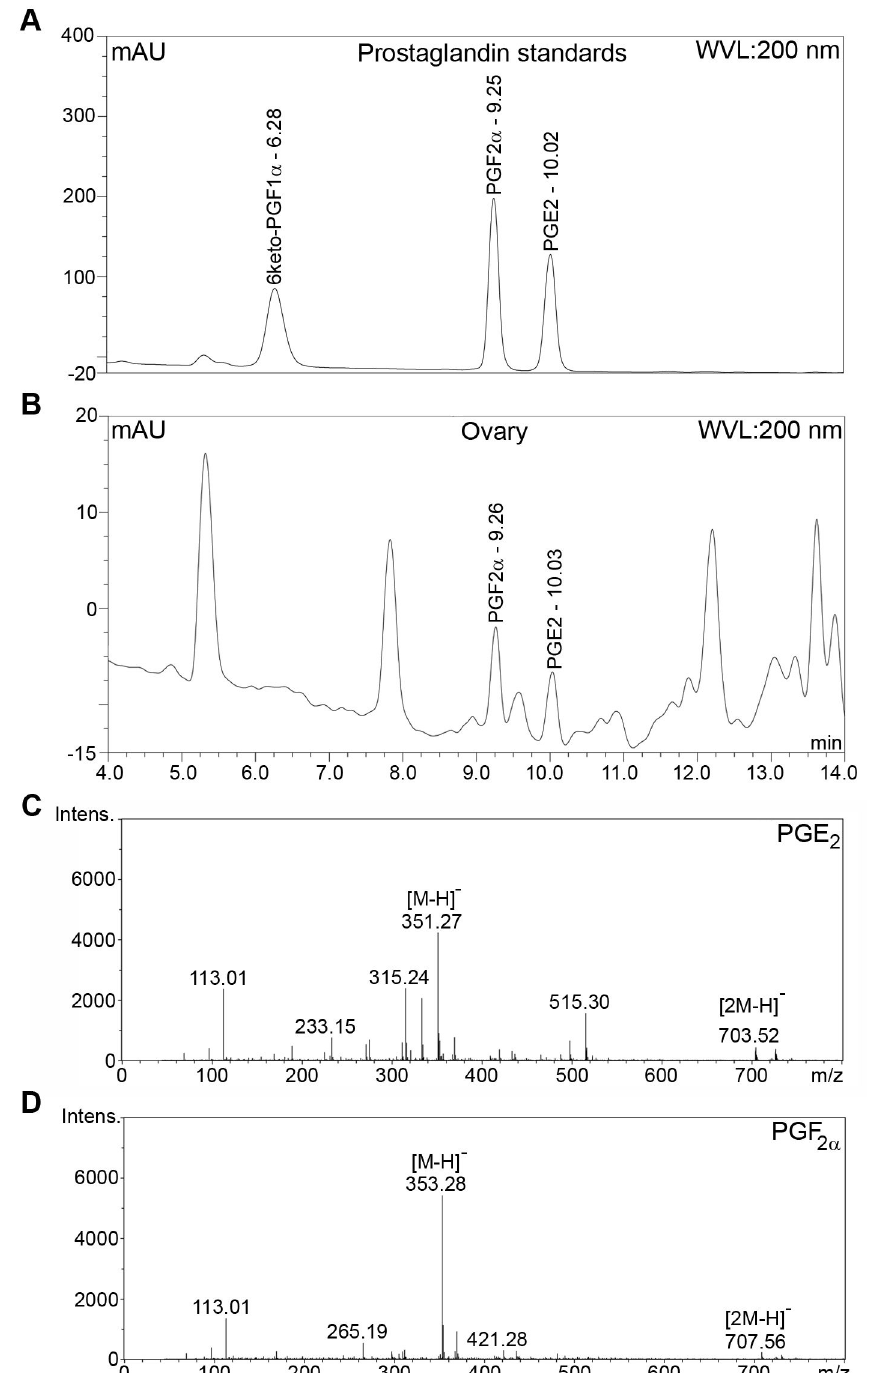
Figure 5. HPLC analysis and mass spectra of the prostaglandins in shrimp ovary extract. Ovaries from 5 wild broodstock were homogenized in HBSS, pooled together and incubated at 28 °C, 200 rpm for 1 h. The homogenate was extracted and analyzed by RP-HPLC and mass spectrometry as described in Materials and Methods. RP-HPLC elution profiles at 200 nm wavelength of commercially available prostaglandin standards (A) and prostaglandins found in ovary homogenate (B). Subsequent mass spectrometry analysis of PG in ovary homogenate yielded mass spectra of PGE